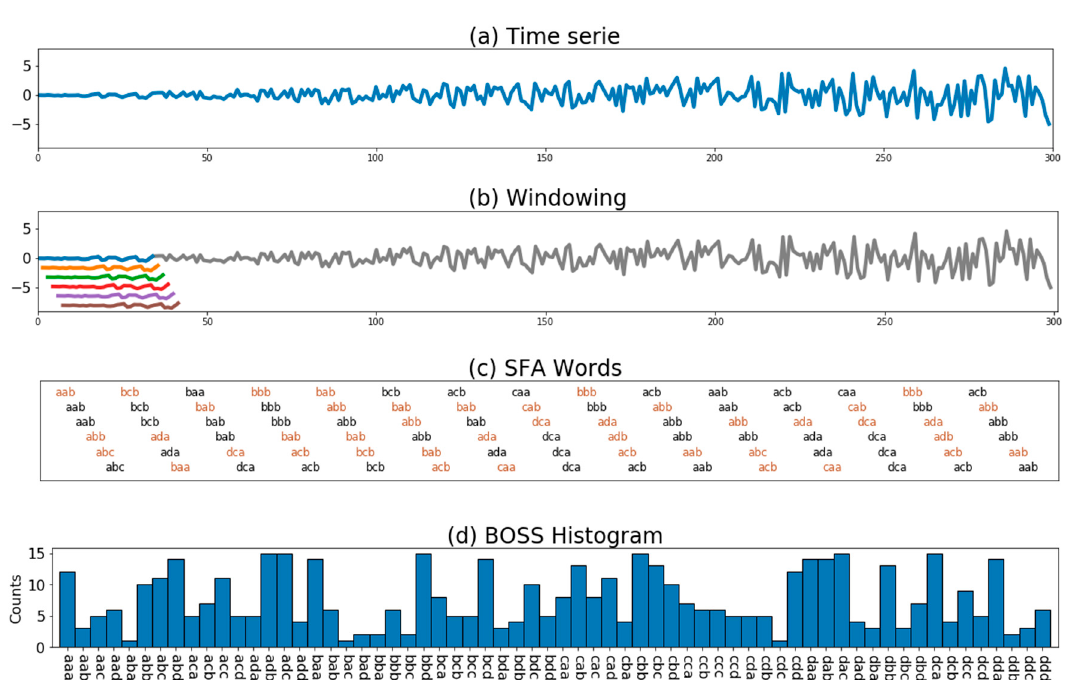
Figure 3. Example of the BOSS model construction: ( a ) a normalized time series; ( b ) windowing process to extract subseries; ( c ) symbolic transformation of SFA with numerosity reduction; and ( d ) histogram construction based on the repetition frequency of the SFA words.